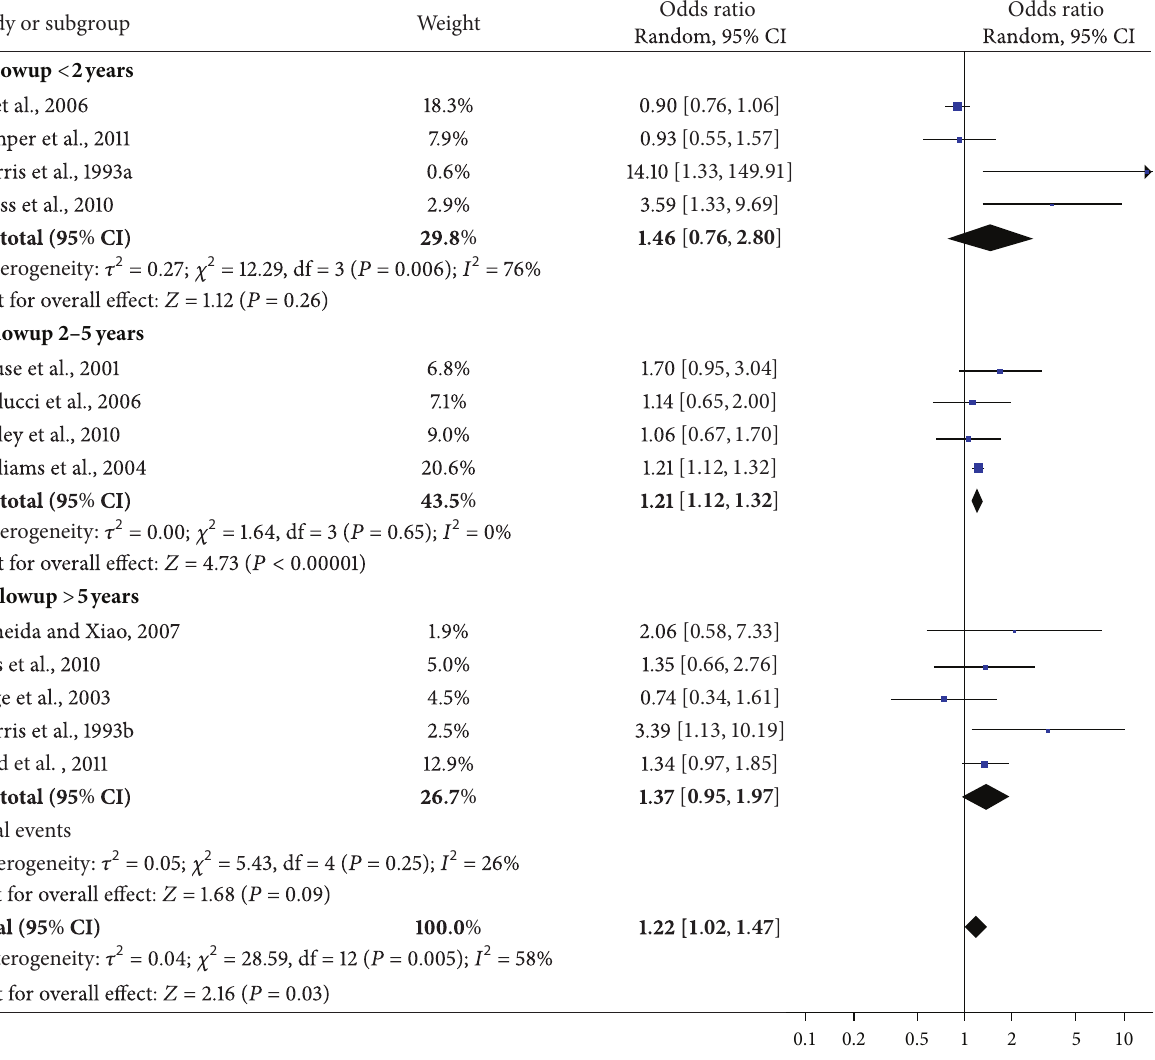
Figure 2: OR of mortality among subjects with depression after